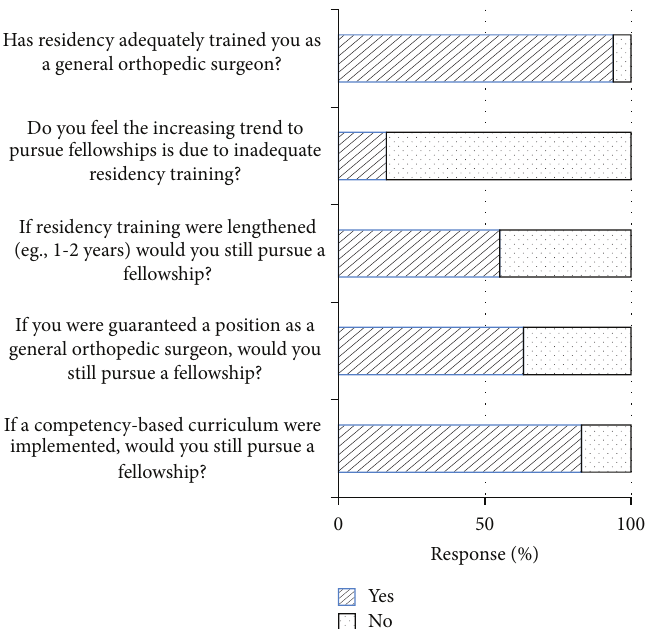
Figure 4: Graphic illustration of responses to various fellowship questions. Horizontal percentage-stacked bars demonstrating the confidence of residents in their residency training with very few considering the growing trend in fellowships a result of inadequate residency training. The majority reporting that neither the offer of employment nor changes to the duration or curriculum of their residencies would dissuade them from pursuing a fellowship.